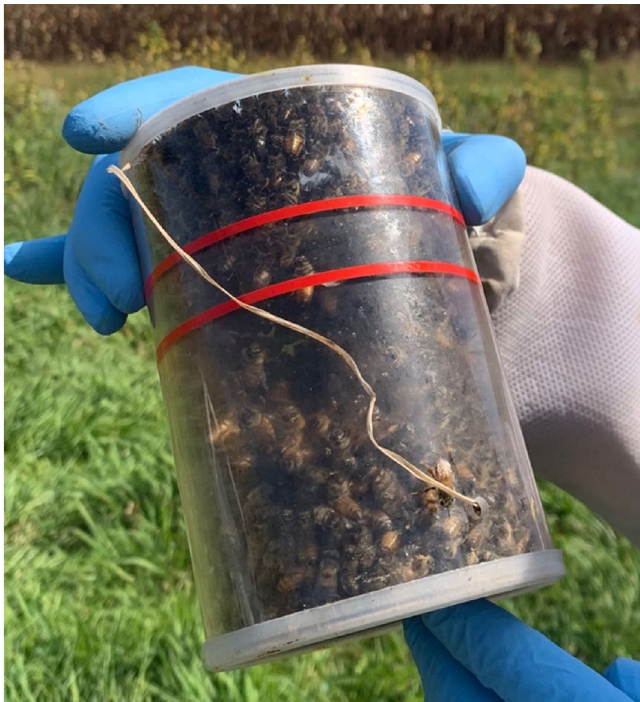
Figure 2. Plastic cylinder with ~ 500 bees before CO 2 was injected.